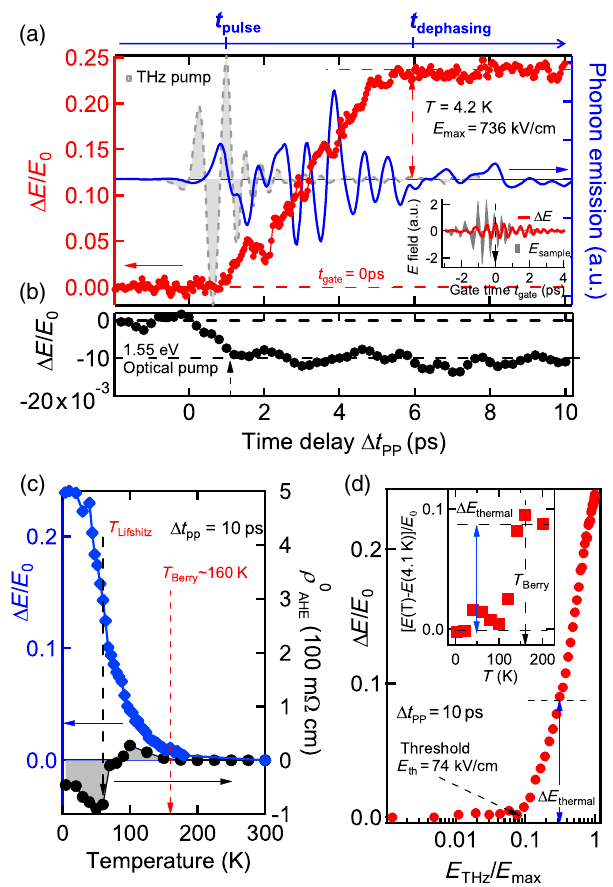
FIG. 2. Light-driven topological phase transition above threshold THz-pump field and at low temperature where the Berry curvature dominates. (a) THz differential transmission ( Δ E=E 0 , red circles) as a function of the pump-probe time delay ( Δ t ) for a peak pump E field of 736 kV = cm. The blue PP trace shows the simultaneously measured phonon emission. The THz-pump trace is shown in gray. The THz differential transmission starts to build up during the coherent phonon emission at much longer times than the pump THz pulse. Inset: Time-domain THz raw data. The transmitted probe E field through the sample E (gray shaded area) and the sample pump-induced transmitted probe E -field change Δ E (red line) ¼ 10 ps are measured by scanning t at Δ t . We normalize PP gate the pump-induced signals by the value of peak amplitude E 0 at the probe THz E field. (b) THz differential transmission for the case of high-energy optical pump (1.55 eV) shows a much faster rise time. (c) Temperature dependence of the differential THz transmission in the metastable state ¼ 10 ps, blue diamonds) indicates strong correlation ( Δ t PP with the Berry-curvature-induced anomalous Hall effect (black solid circles). (d) Pump E -field dependence of the THz differ- ¼ 10 ps), ential transmission for the THz pump at ( Δ t PP indicating a threshold pump field for the formation of the metastable state. Inset: The thermal topological change Δ E required for the thermally driven STI-DP-WTI tran- thermal sition is determined by the change of THz-field transmission between 4.1 and 160 K ( T ). Berry